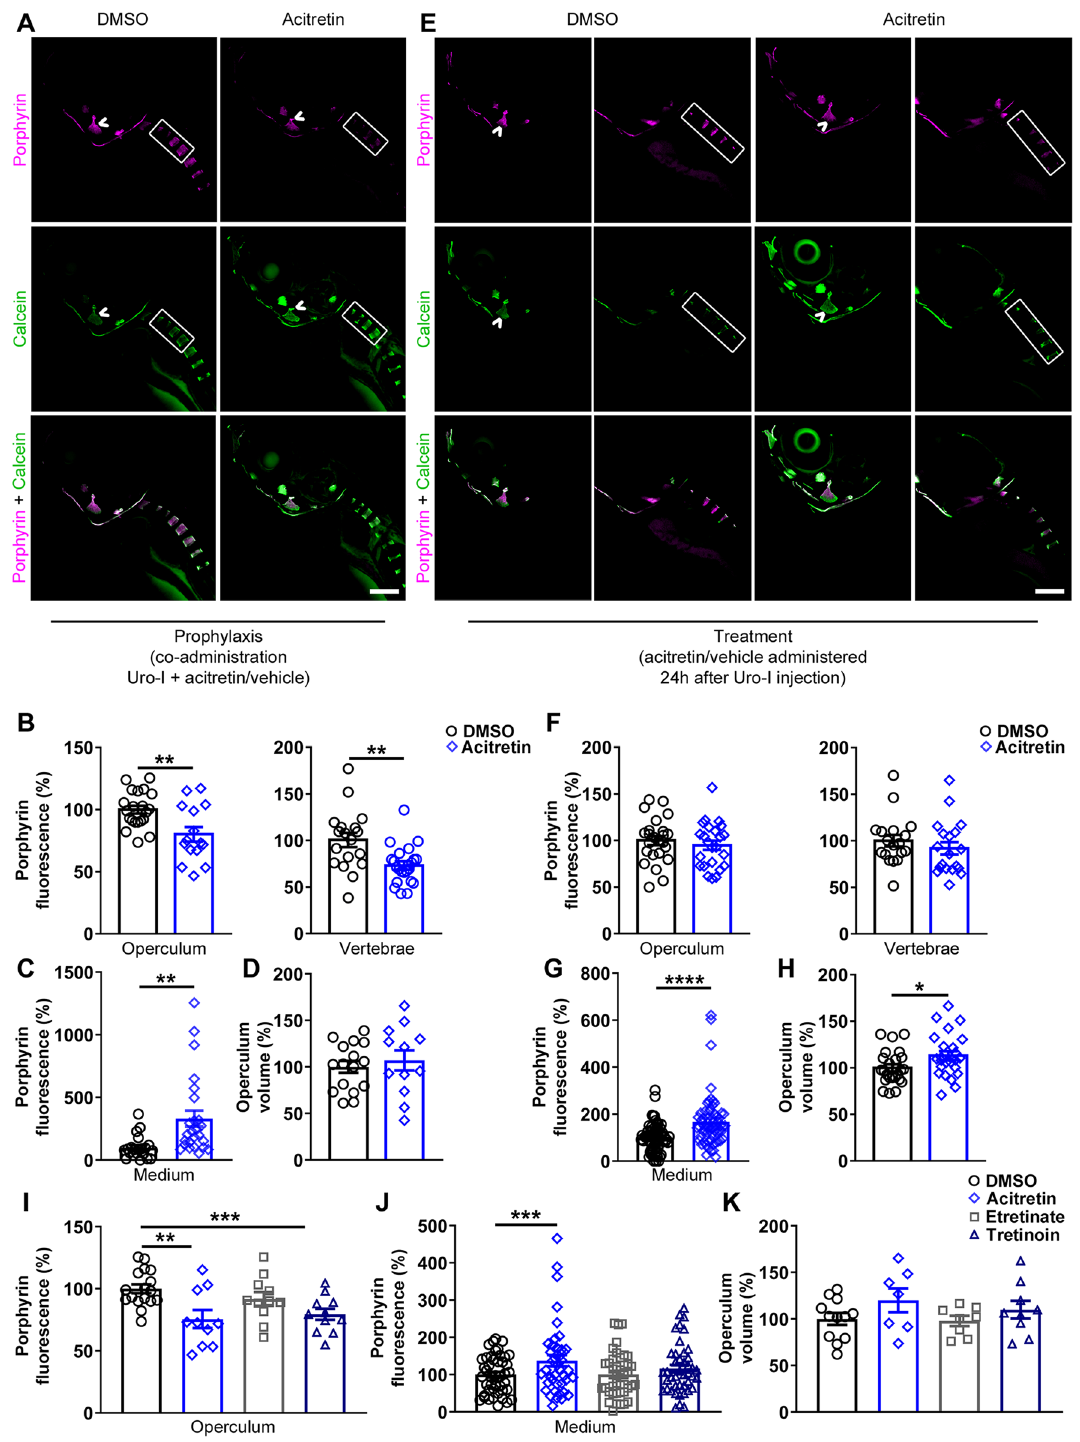
Figure 2. Acitretin mitigates CEP bone phenotype in zebrafish. ( A ) 6dpf larvae were injected with uro-I and transferred to medium containing acitretin or DMSO. At 7dpf larvae were injected with calcein and imaged by confocal microscopy. Quantification of porphyrin fluorescence ( B ), porphyrin excretion ( C ) and operculum volume ( D ) from experiment in ( A ). Symbols represent individual larvae (12–25/group) from 3–4 independent experiments. ( E ) 6dpf larvae were injected with uro-I. At 7dpf they were transferred to medium containing acitretin or DMSO. At 8dpf larvae were injected with calcein and imaged by confocal microscopy. Quantification of porphyrin fluorescence ( F ), porphyrin excretion ( G ) and operculum volume ( H ) from experiment in ( E ). Arrowhead-operculum; box-vertebrae ( A , E ). Symbols represent individual larvae (18–64/group) from 3–4 independent experiments. ( I-K ) Larvae were treated as in ( A ) with the indicated retinoid or DMSO and porphyrin fluorescence ( I ), porphyrin excretion ( J ) and operculum volume ( K ) were assayed. Bone volume was normalized to DMSO-treated larvae set to 100%, ( D , H , K ). Porphyrin excretion was normalized to DMSO-treated larvae set to 100%, ( C , G , J ). Symbols represent individual larvae (7–44/group) from 2–4 independent experiments. Scale bars: 200 µm. Three-dimensional image reconstruction ( A , E ) was performed using Imaris 3D software v7.7 (http:// imaris. oxinst. com/). * p < 0.05, ** p < 0.01, *** p < 0.001, **** p <